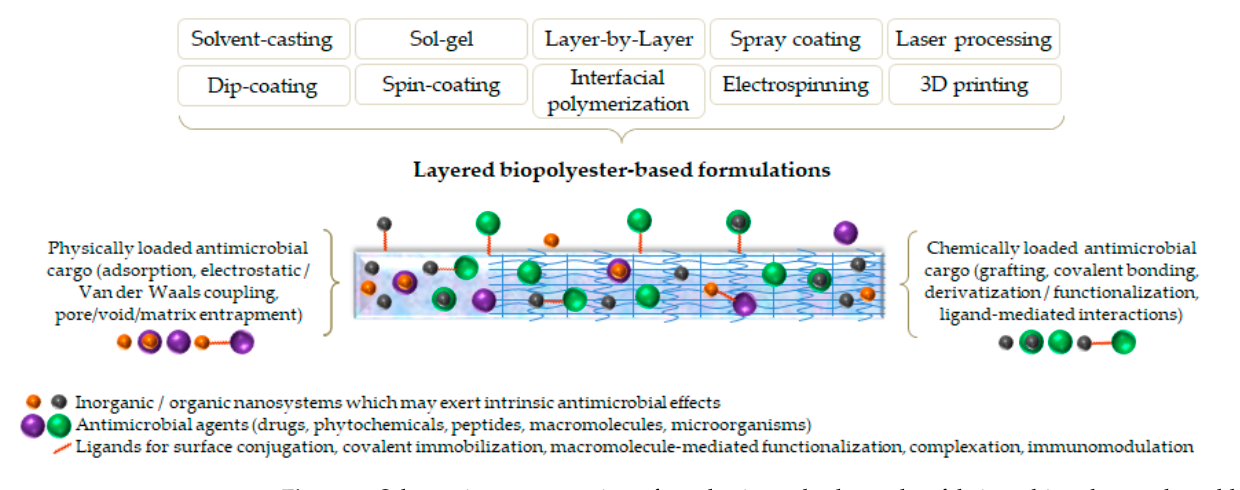
Figure 3. Schematic representation of synthesis methods used to fabricate biopolyester-based lay- ered formulations.